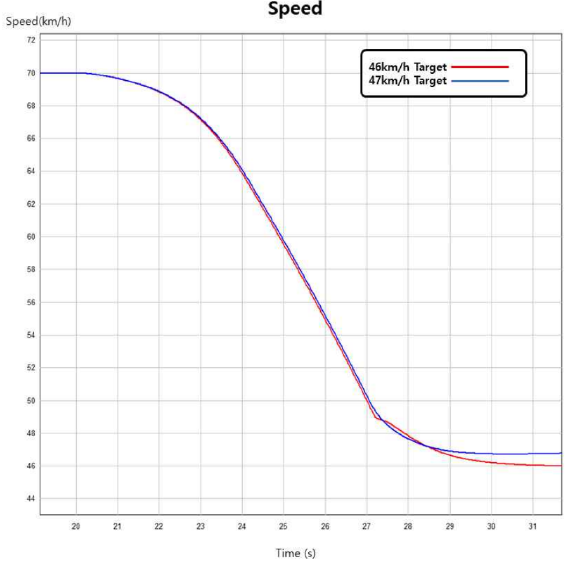
Figure 27. Maximum braking comparison when setting target speed as 46 and 47 km/h. Note that the initial speed is 70